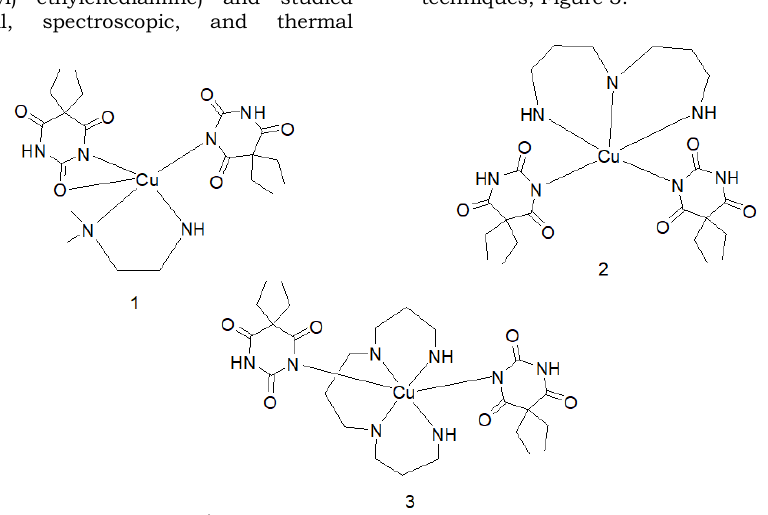
Fig. 3 . Structure of three new copper(II) complexes